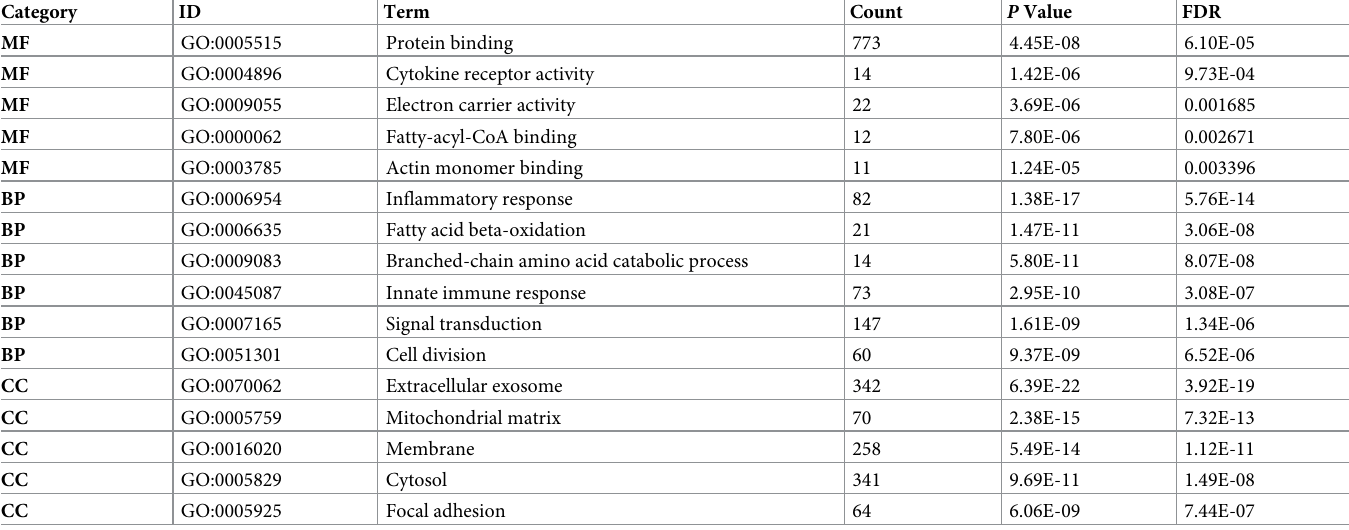
Table 1. Results of GO analysis of PLAUR coexpressed